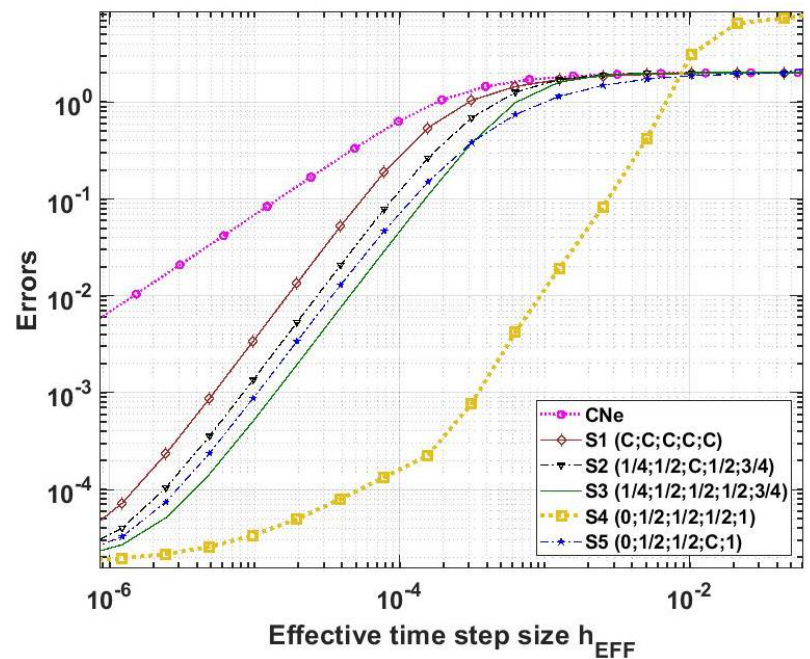
L h Figure 8. The for the u 2 solutions of the heat equation for 1  . Figure 8. The L ∞ errors as a function of h EFF for the u 2 solutions of the heat equation for α = 1.  errors as a function of EFF We also present the graphs of the initial function u 2 ( x , t 0 = 0.5 ) , the analytical We also present the graphs of the initial function ( x , t ) , and two corresponding numerical solutions for h = 2 × 10 − 4 in solution u exact fin 2 , and two corresponding numerical solutions for in Figure Figure 9. We emphasize that, at this time step size range, the algorithm S4 was the